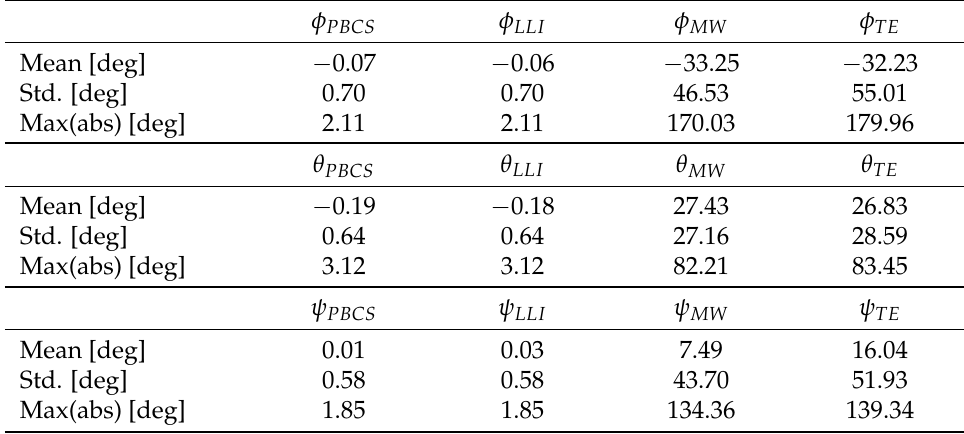
Table 9. Attitude angle difference statistics from KVH unit—Case Study 2.